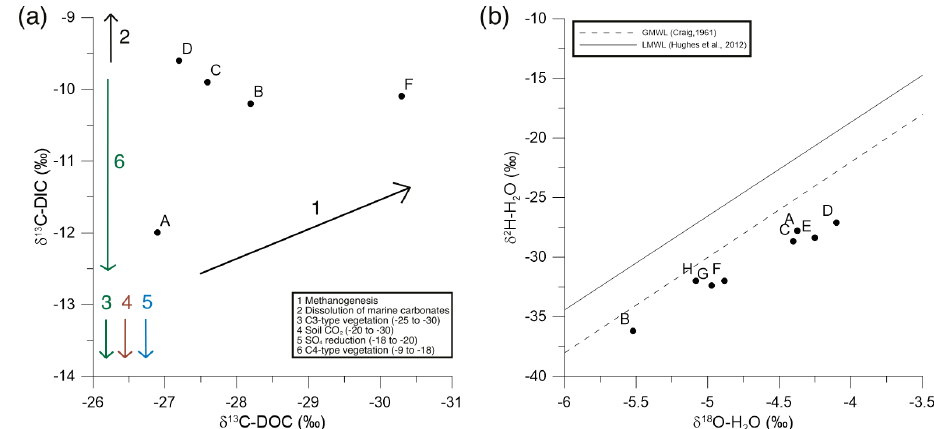
Figure 5. (a) A plot of δ 13 C-DOC vs. δ 13 C-DIC. There is no correlation between these geochemical data, indicating that there is no methanogenic end member in our samples. Samples E, G and H are omitted because they were below the detection limit for δ 13 C-DOC (Table S1 in the Supplement). Arrow 1 delineates the expected trend for methanogenesis, and arrow 2 is the expected trend for the dissolution of marine carbonates (Currell et al., 2016). Arrows 3–6 highlight expected ranges for δ 13 C-DIC that are off the scale of the graph (Currell et al., 2016). (b) A plot of δ 18 O-H 2 O vs. δ 2 H-H 2 O showing that there is no 2 H enrichment in any of the groundwater samples. The GMWL (global meteoric water line; Craig, 1961) and LMWL (local meteoric water line; Hughes and Crawford, 2012) are also